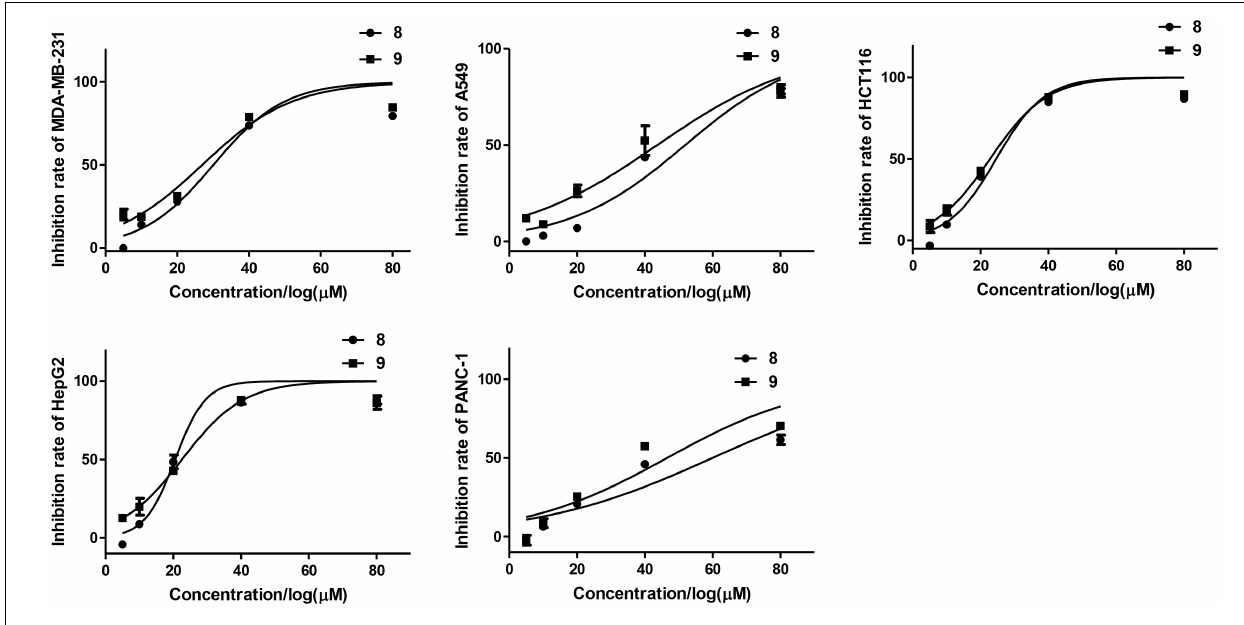
FIGURE 8 | Inhibition rates of tested cell lines of compounds 8 and 9 .